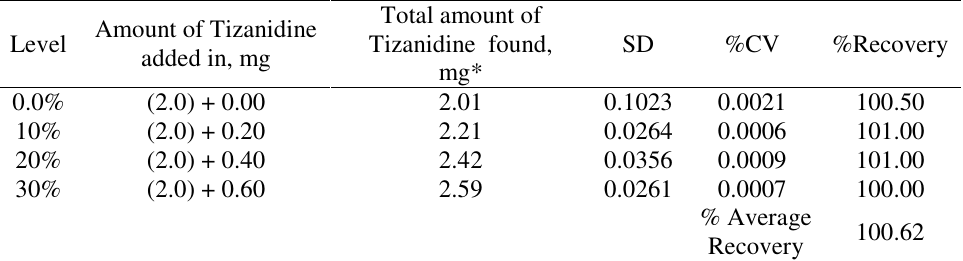
Table 4. Results from recovery analysis for tizanidine